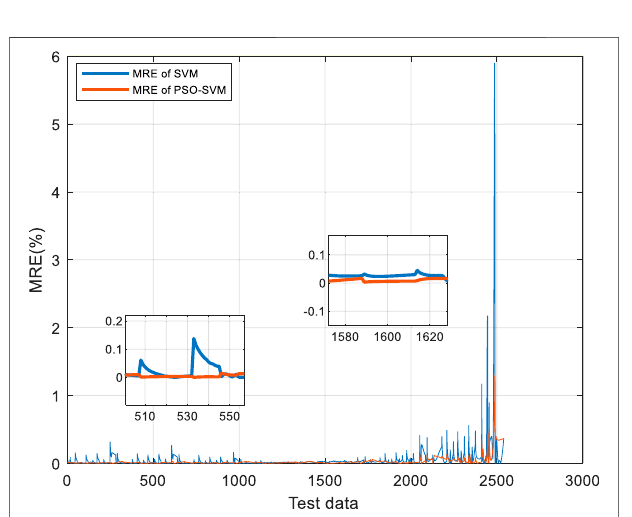
FIGURE 16 | The MRE of SOC estimation under DST operating conditions.